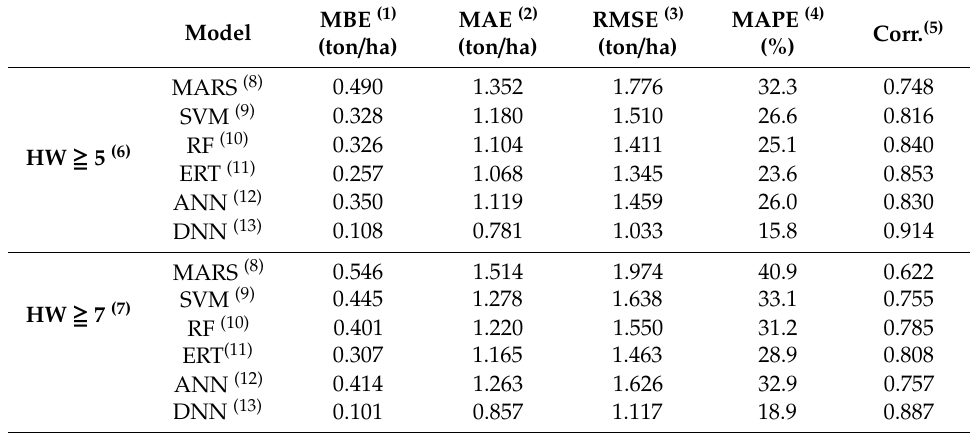
Table 7. Summary of validation statistics for prediction of corn yield during heatwaves longer than five and seven consecutive days obtained from leave-one-year-out blind tests for